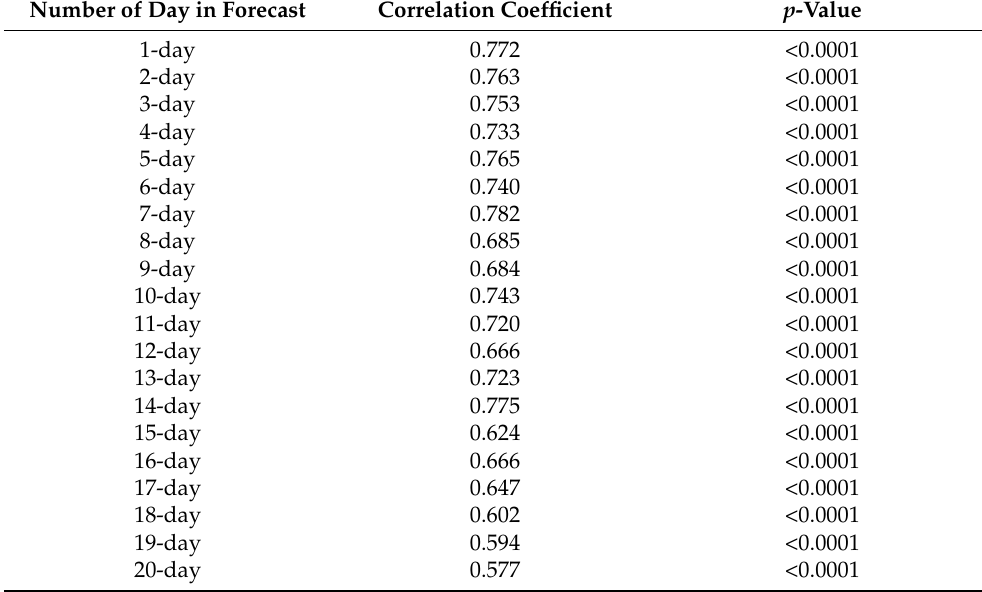
Table 4. Correlation between the prediction of seven-day moving average ED visits with fever and daily number of influenza patients in NHIS from 2018 to 2019. We estimated the seasonal ARIMA(1,1,1)(0,0,1) 7 model to forecast hospital visits due to influenza based on a seven-day average ED visits with fever. Number of Day in Forecast Correlation Coefficient p -Value 1-day 0.772 <0.0001 2-day 0.763 <0.0001